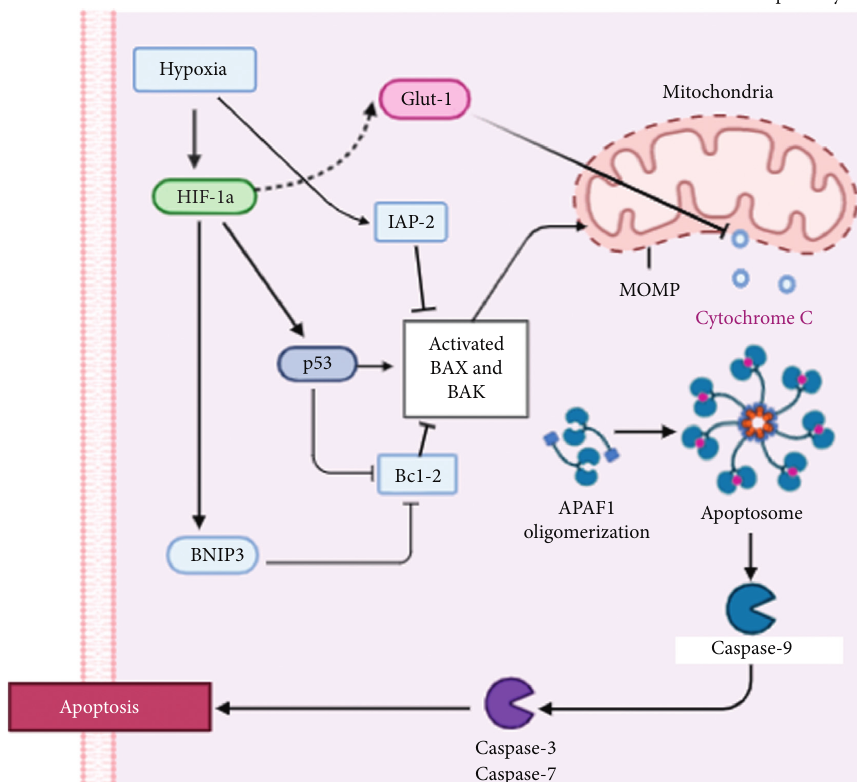
Figure 4: Schematic representation of hypoxia-induced proapoptotic and antiapoptotic signalling pathways. The involvement of HIF-1 α is described in these pathways. The solid lines indicate a direct interaction; the dashed line indicates an indirect interaction. Induction (arrow); inhibition (headless arrow). APAF-1, cytochrome C, and procaspase 9 form the apoptosome that activates caspase 9. APAF-1: apoptotic protease activating factor 1; BNIP3: protein 3 that interacts with BCL-2/adenovirus E1B of 19kDa; HIF-1 α : hypoxia-inducible factor 1; IAP- 2: inhibitor of apoptosis protein 2; GLUT1: glucose transporter; MOMP: mitochondrial outer membrane permeabilisation; caspase 9 (inducer); caspases 3 (irreversible apoptosis marker); caspase 7 (effector). By Katherine J. Palma Valladares with